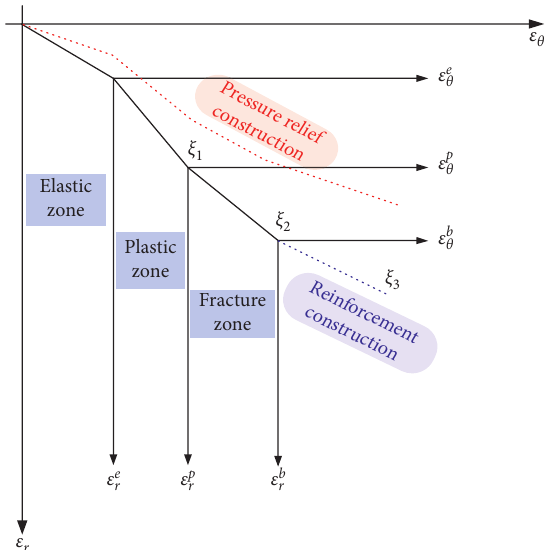
Figure 7: Strain model of roadway surrounding